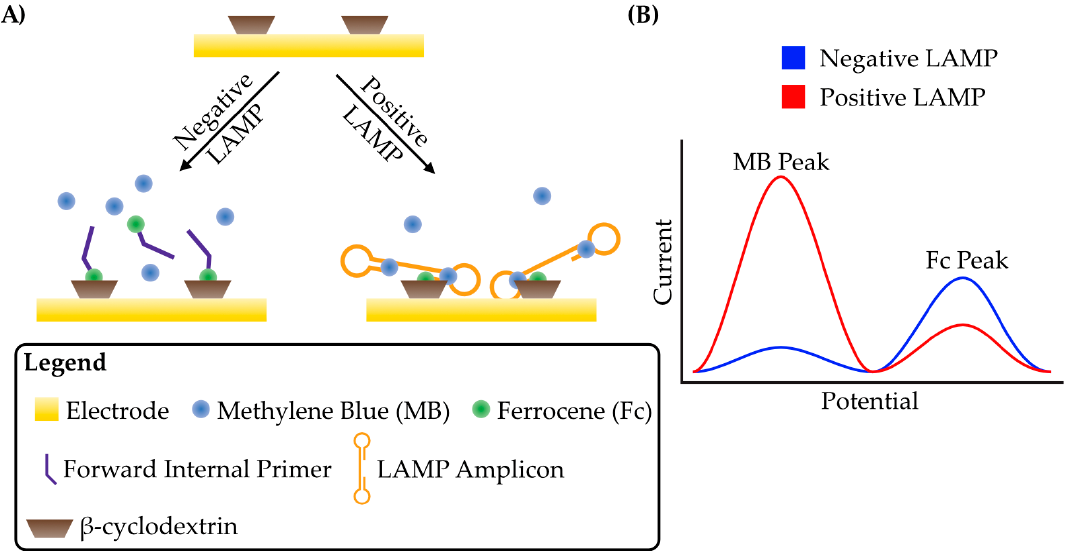
Figure 3. Schematic strategy for the detection of LAMP amplicons by concentrating electroactive species near the electrode surface. ( A ) An electrode is functionalized with β -cyclodextrin. The forward internal primer (FIP) of LAMP is conjugated to ferrocene such that it can be incorporated into the LAMP amplicons. Ferrocene can also bind to β -cyclodextrin. In a negative reaction, Fc-FIP will bind to β -cyclodextrin, producing a relatively large peak faradaic current. Methylene blue in solution will also produce a faradaic current at a different potential. In a positive LAMP reaction, Fc-FIP tethers entire amplicons to the electrode surface. The dsDNA is bound by methylene blue and produces a large ratiometric current between ferrocene and methylene blue. Adapted from [59]. ( B ) Schematic of a typical voltammogram for this detection strategy. Two peaks are observed at different potentials due to the presence of two electroactive species. While ferrocene is brought close to the electrode through interactions with β -cyclodextrin in both positive and negative LAMP reactions, the incorporation of free Fc-labelled primers into LAMP amplicons reduces their diffusivity and therefore the peak faradaic current decreases. For methylene blue, intercalation into LAMP amplicons effectively concentrates it at the electrode surface and results in an increased peak faradaic